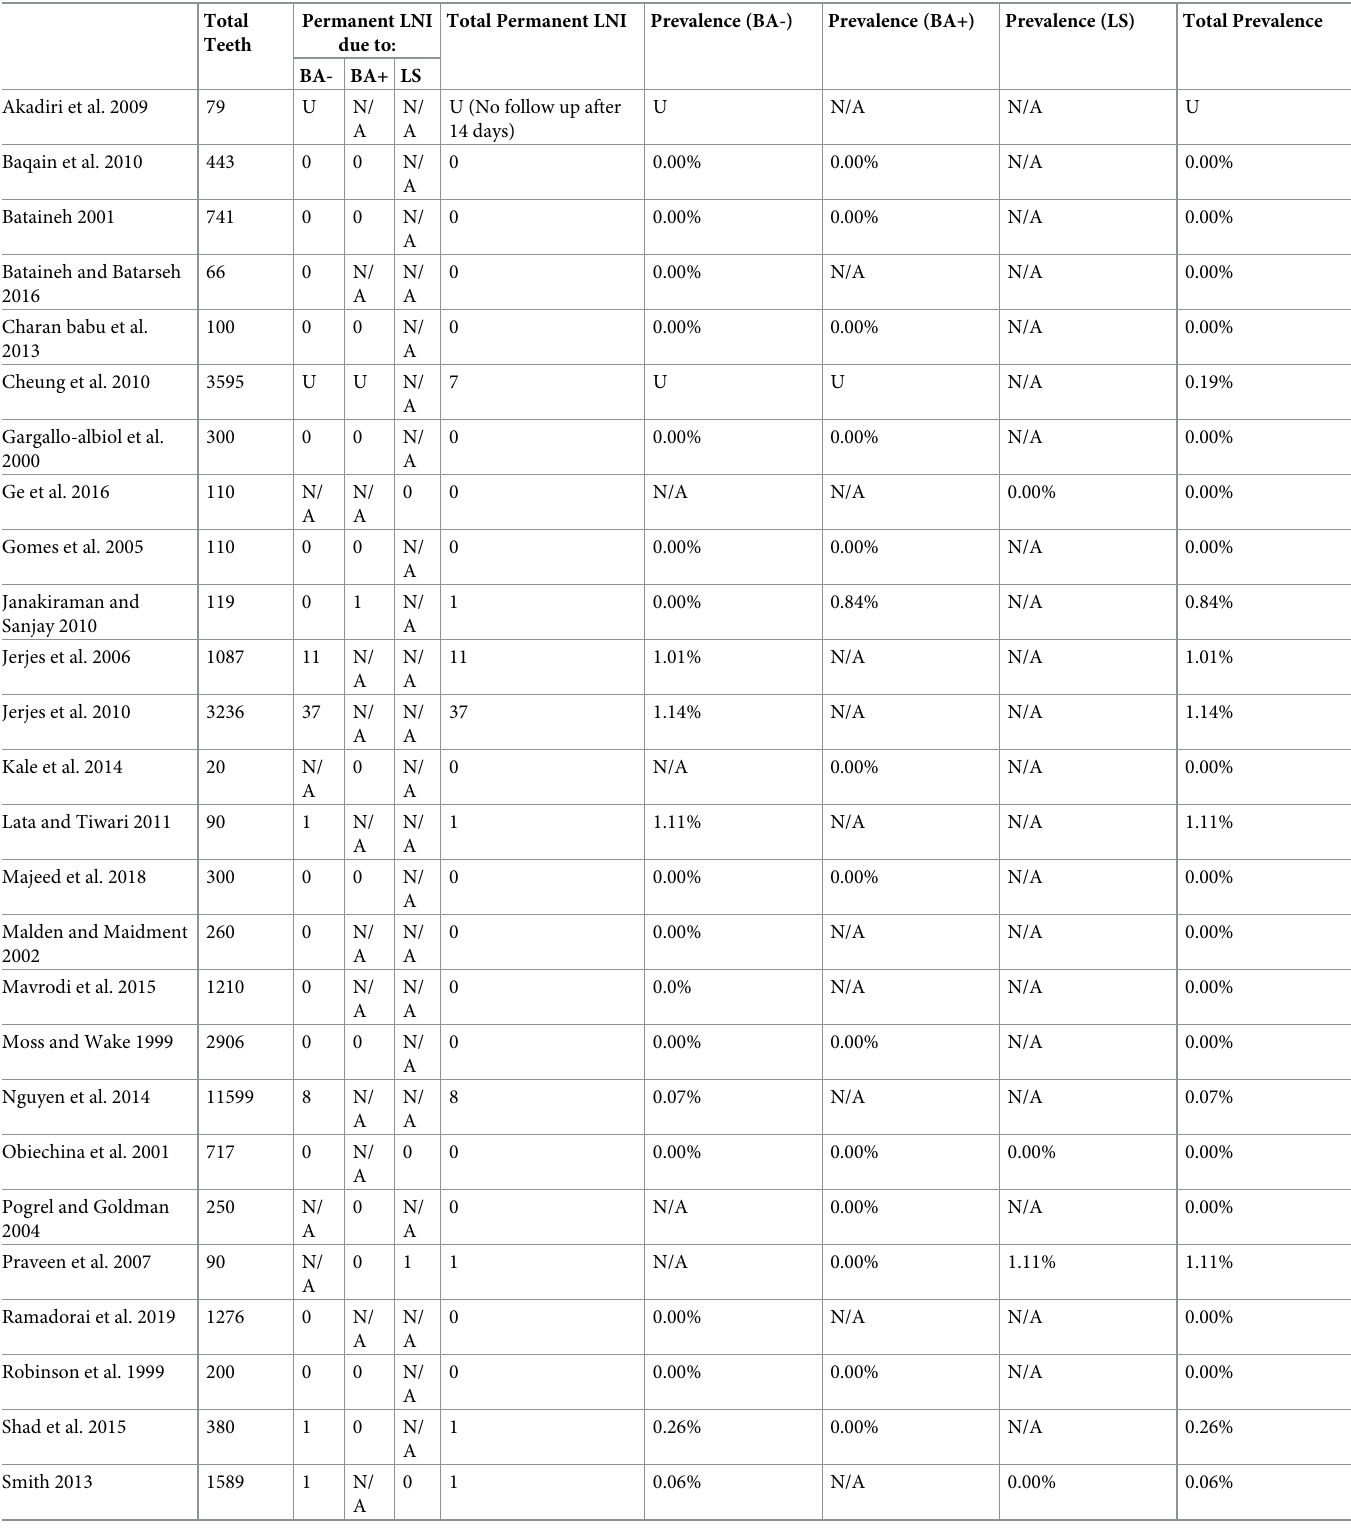
Table 4. Prevalence of permanent LNI using BA-, BA+ and